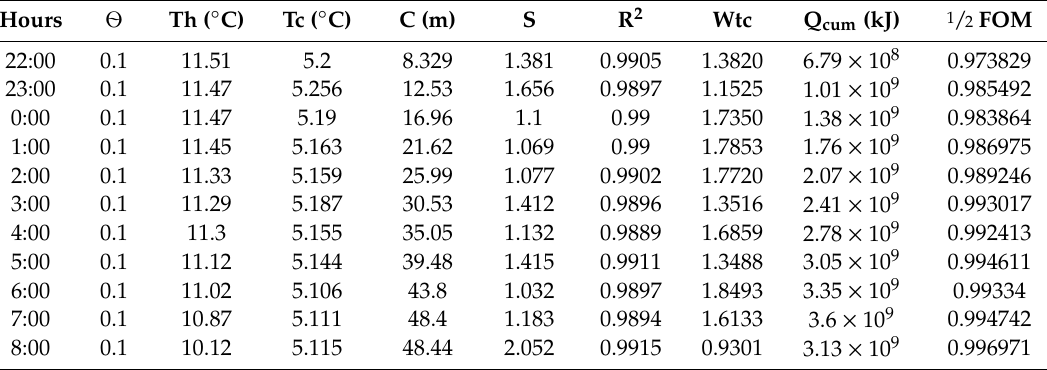
Table A6. 6th–7th January 2019 Curve Fitting and Performance Parameter